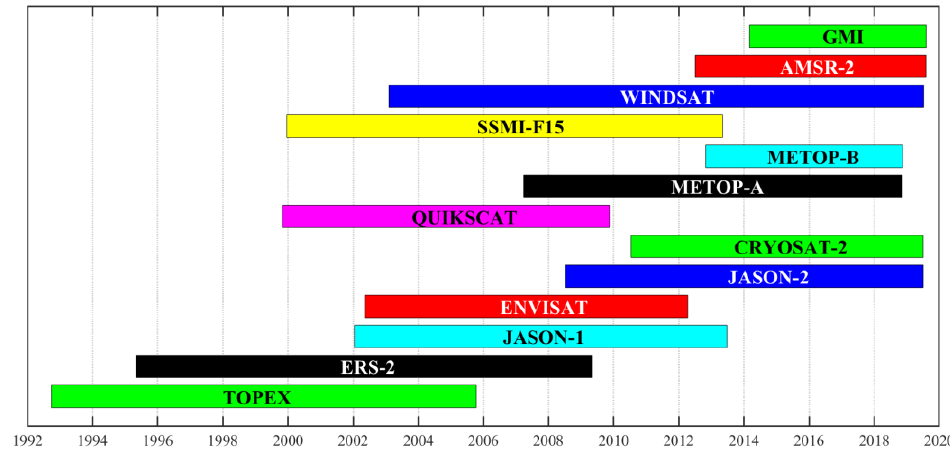
Figure 1. Durations of all satellite data used for the present analysis.